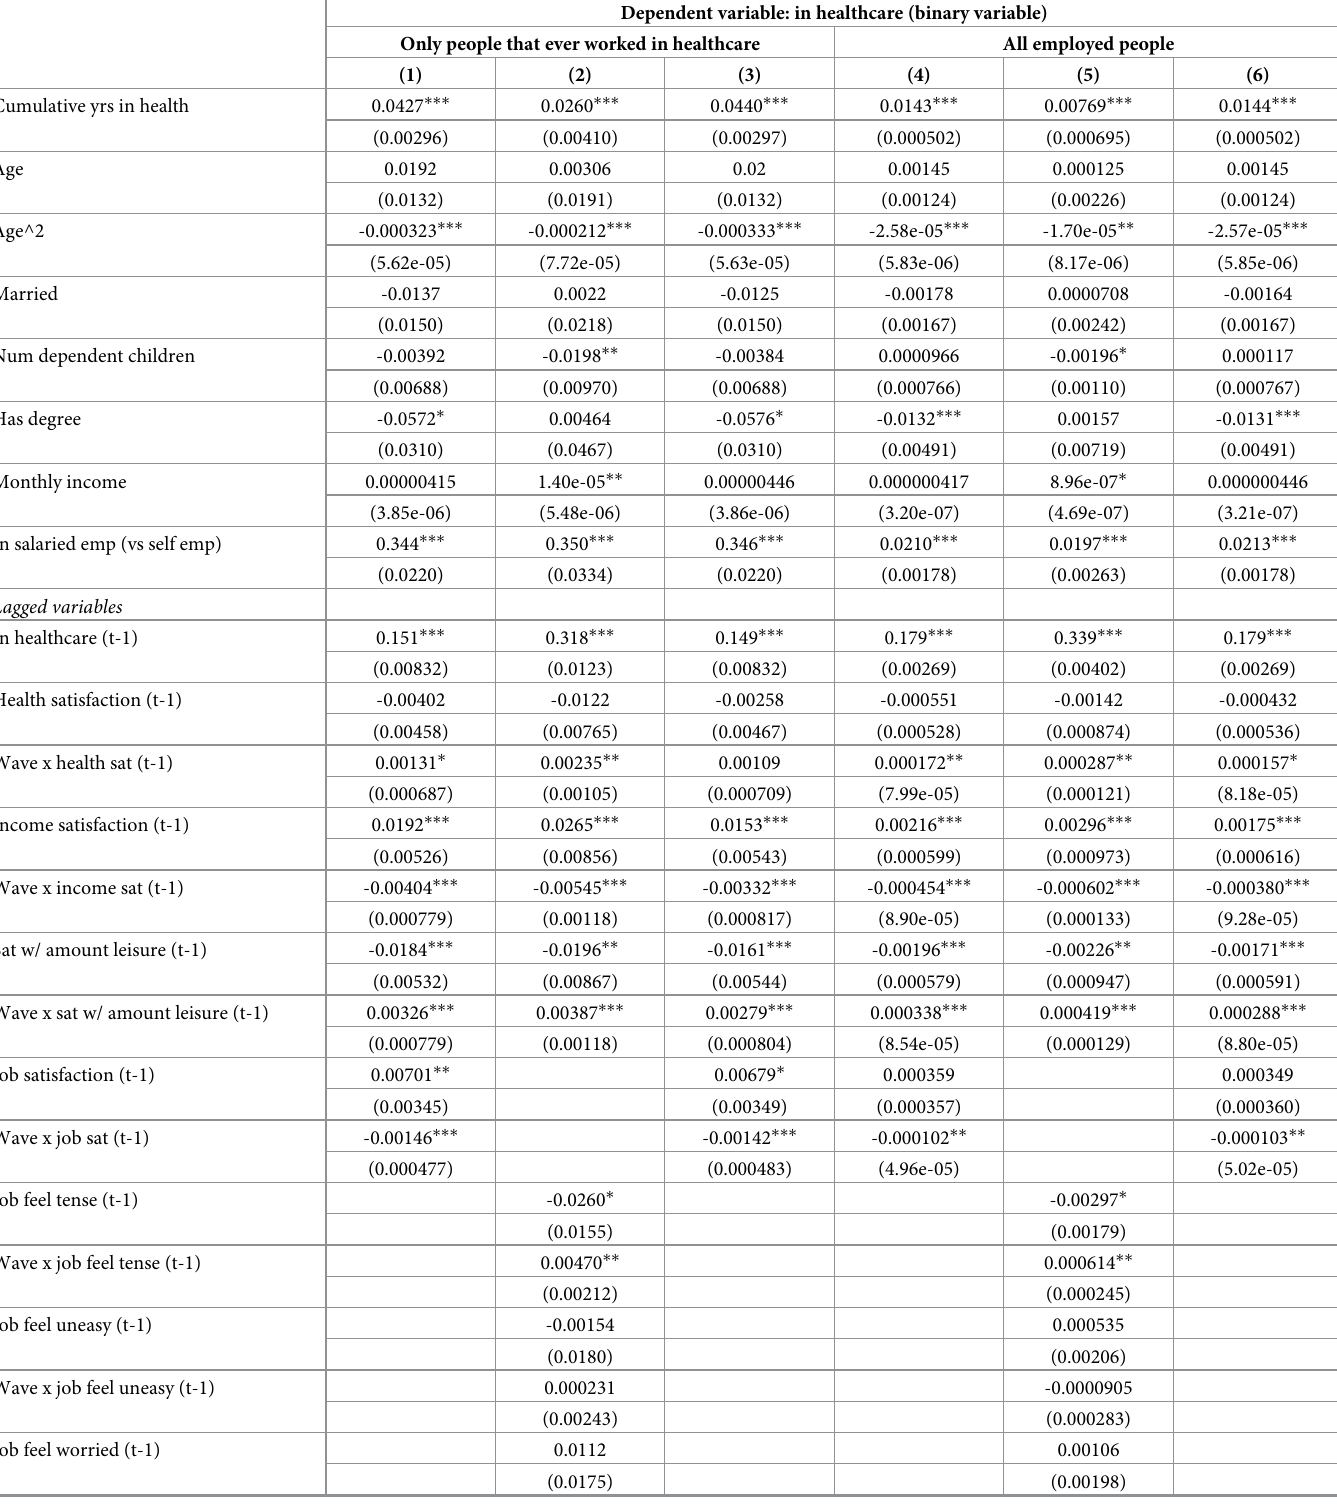
Table 2. Fixed-effects OLS regressions predicting whether individuals were working in healthcare from current and lagged variables. Dependent variable: in healthcare (binary